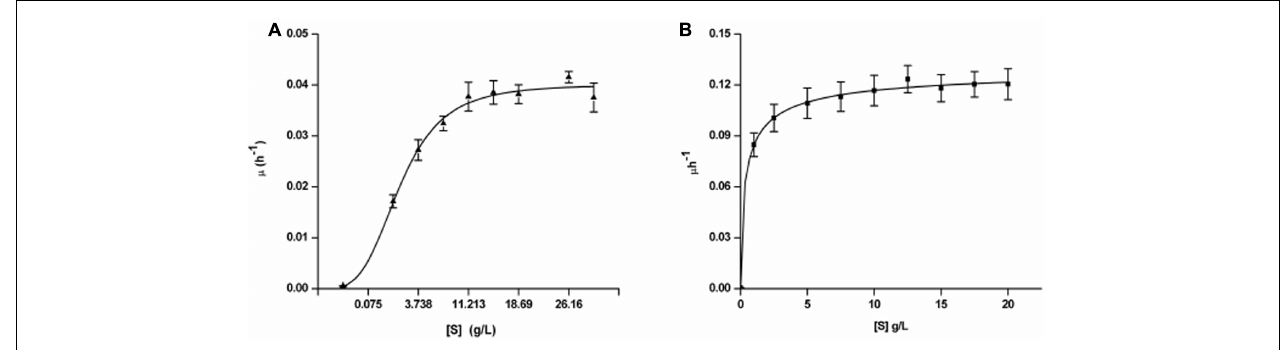
FIGURE 1 | Growth kinetics of Yarrowia lipolytica NCIM 3589 on varying initial concentrations of (A) BrB; (B) Glucose.